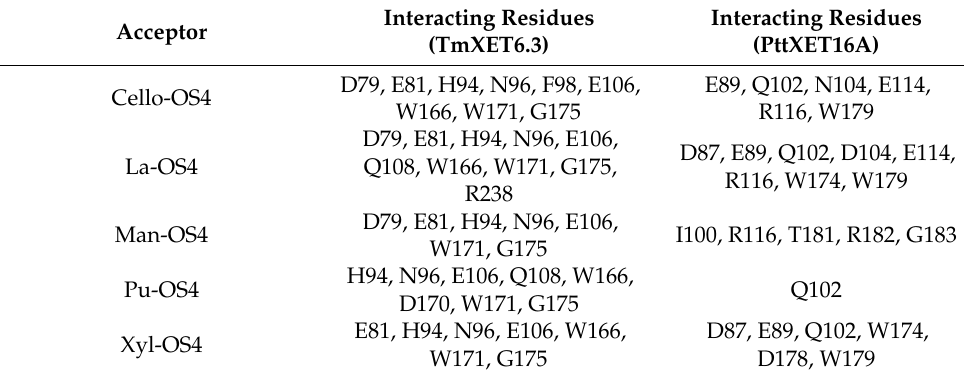
Table 4. The TmXET6.3 and PttXET16A residues that interact with linear acceptors over 50% of MD simulation times at distances of up to 4.0 Å.